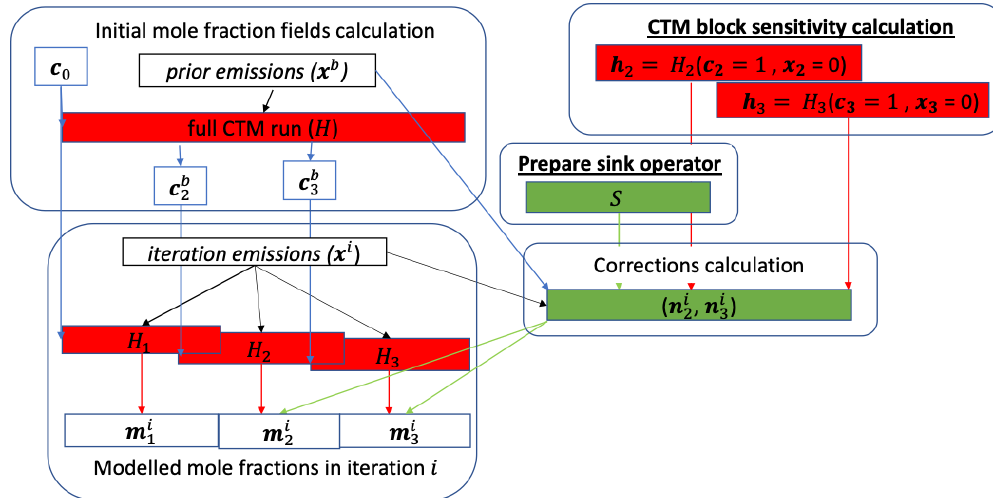
Figure 1. Schematic diagram of a PP methane inversion’s forward mode, which computes mole fractions m i in iteration i . The steps shown with red boxes use CTM runs and require a long wall time. The steps shown in green are without CTM runs and require negligible wall time. The subscripts denote the block numbers (except for c 0 , which is the initial mole-fraction field at the start of the inversion). For block i ) is not needed. The overlap between the successive blocks = c 1, the initial mole-fraction field ( c b 0 ) and mole-fraction correction vector ( n 1 ( H 1 , H 2 , H 3 ) represents the overlap period, where the modeled mole fractions from the preceding block are used in the inversion. The “CTM block sensitivity calculation” and “Prepare sink operator” steps of the PP method are implemented in this study, whereas the rest are from Chevallier (2013). Note that the diagram illustrates the PP splitting into only three blocks, whereas more blocks are used in practice, depending on the inversion